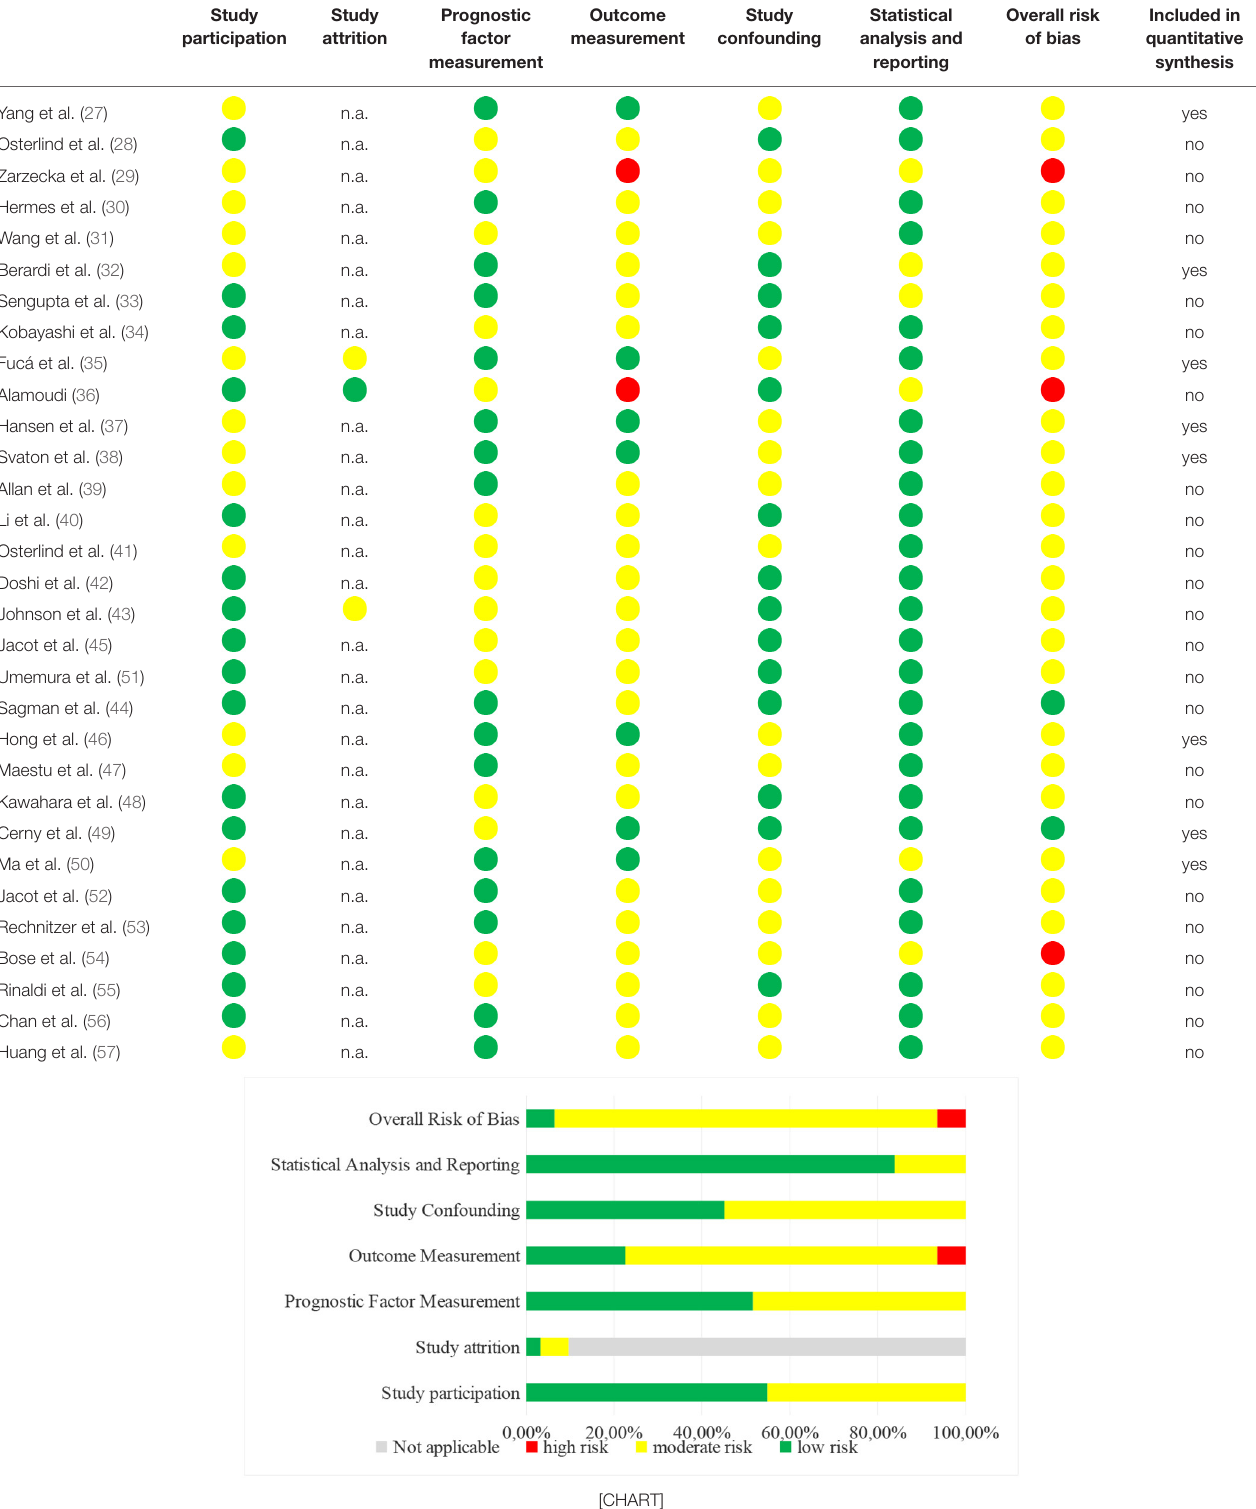
TABLE 4 | Risk of bias assessment.